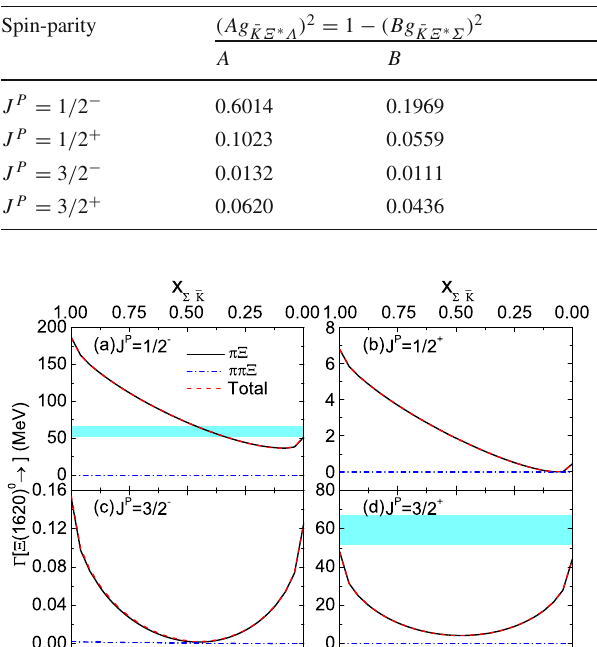
and g ¯ K Ξ ∗ Σ K Ξ ∗ Λ